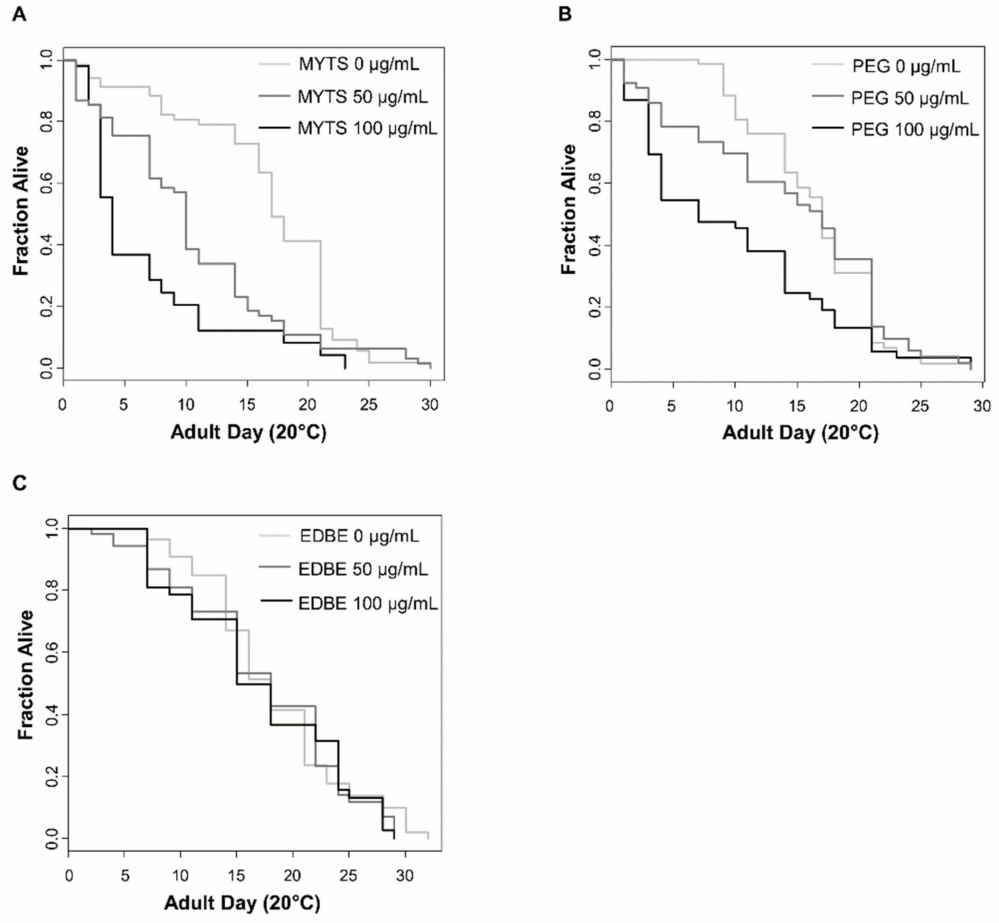
Figure 5. Effect of MYTS, MYTS-PEG or MYTS-EDBE on C. elegans lifespan. One-day synchronized worms were transferred in NGM plates with or without 50 or 100 µ g/mL unconjugated MYTS ( A ), MYTS-PEG ( B ), MYTS-EDBE ( C ), respectively.